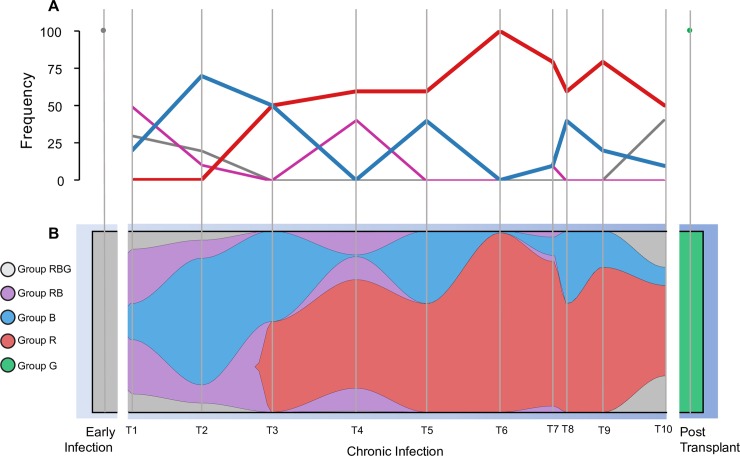
Population genomics of the community over time.Groups R, B, G, RB, and RBG are coloured in red, blue, green, purple, and grey respectively. (A) Frequency of each group over time. (B) The clonal graph was created with the assumption that RBG is the group of isolates resembling the ancestor of all the isolates, and RB is the group of isolates resembling the ancestor of group R and B. The distance between sample times is relative to the actual number of days between them. This plot was created using fishplot v. 0.3 [92].